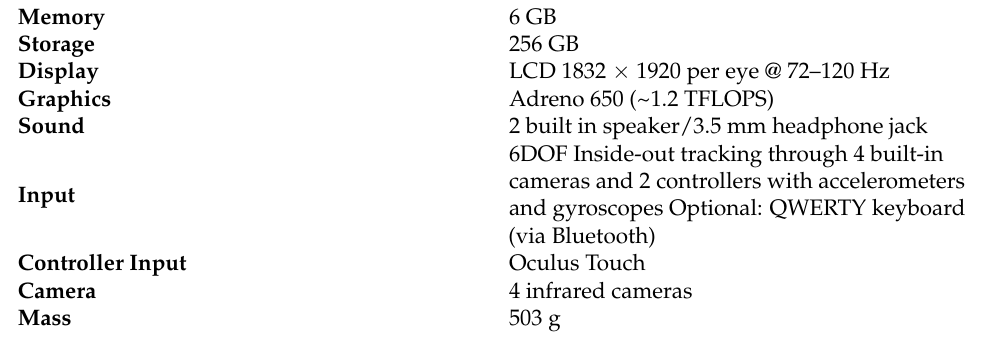
Figure 1. Oculus Quest 2. From the left, the head-mounted display, the left controller (Controller A), and right controller (Controller B). Table 1. Main features of Oculus Quest 2.